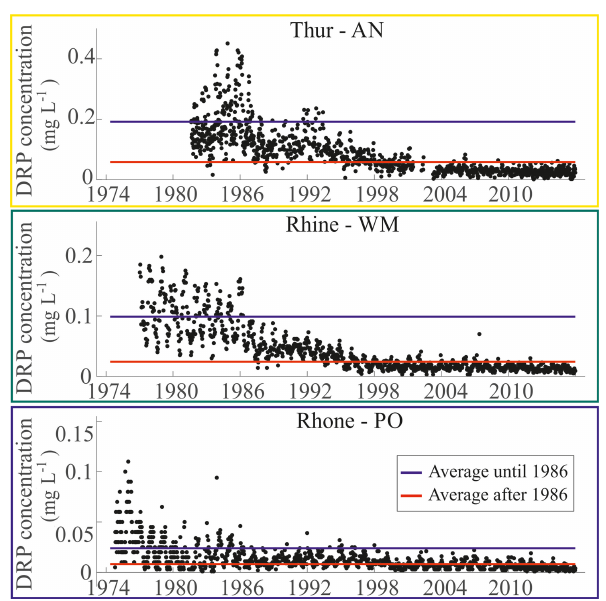
Figure 6. Observed DRP concentrations in three catchments char- acterized by different classes (i.e., Thur, AN; Rhine, WM; and Rhone, PO). The blue line represents the mean until 1986, whereas the red line represents the mean after 1986 and until the end of the monitoring period. After the introduction of the phosphate ban in 1986, the DRP concentrations have shown an evident